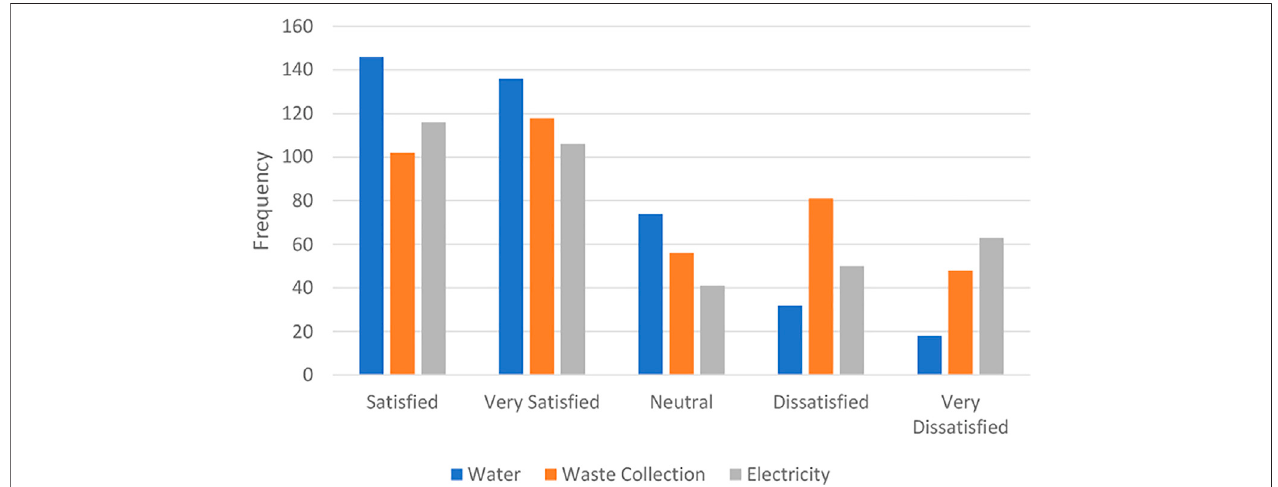
FIGURE 5 | Chart showing the level of satisfaction with available services. Source: Field work, 2020.